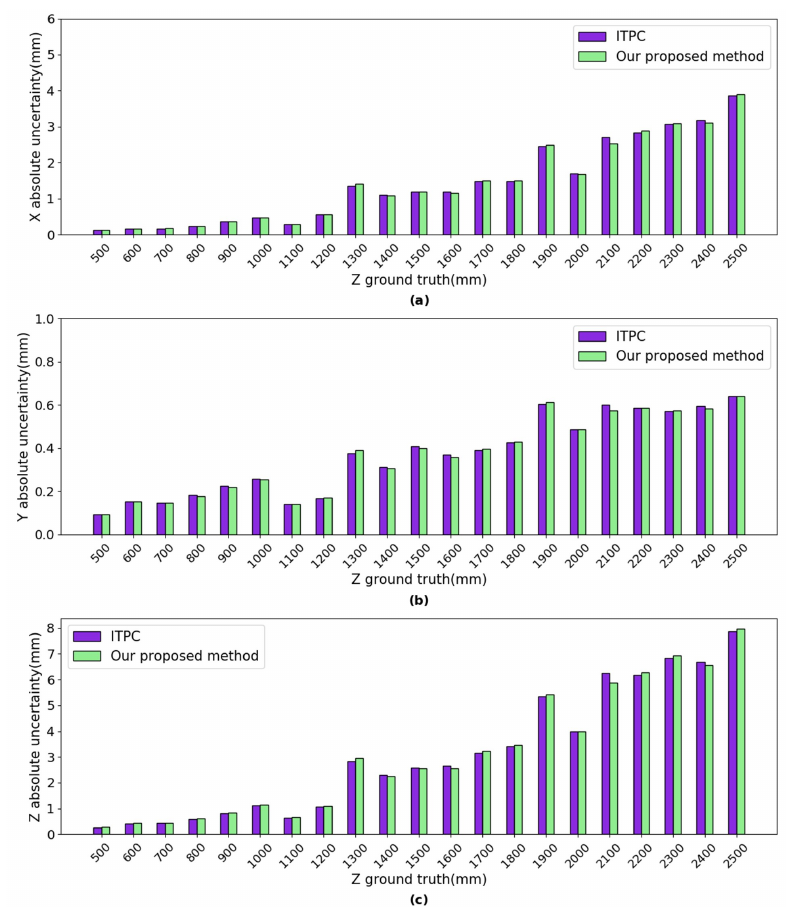
Figure 11. The uncertainties of our proposed method and ITPC method. ( a ) absolute uncertainty in X axis; ( b ) absolute uncertainty in Y axis; and, ( c ) absolute uncertainty in Z axis.